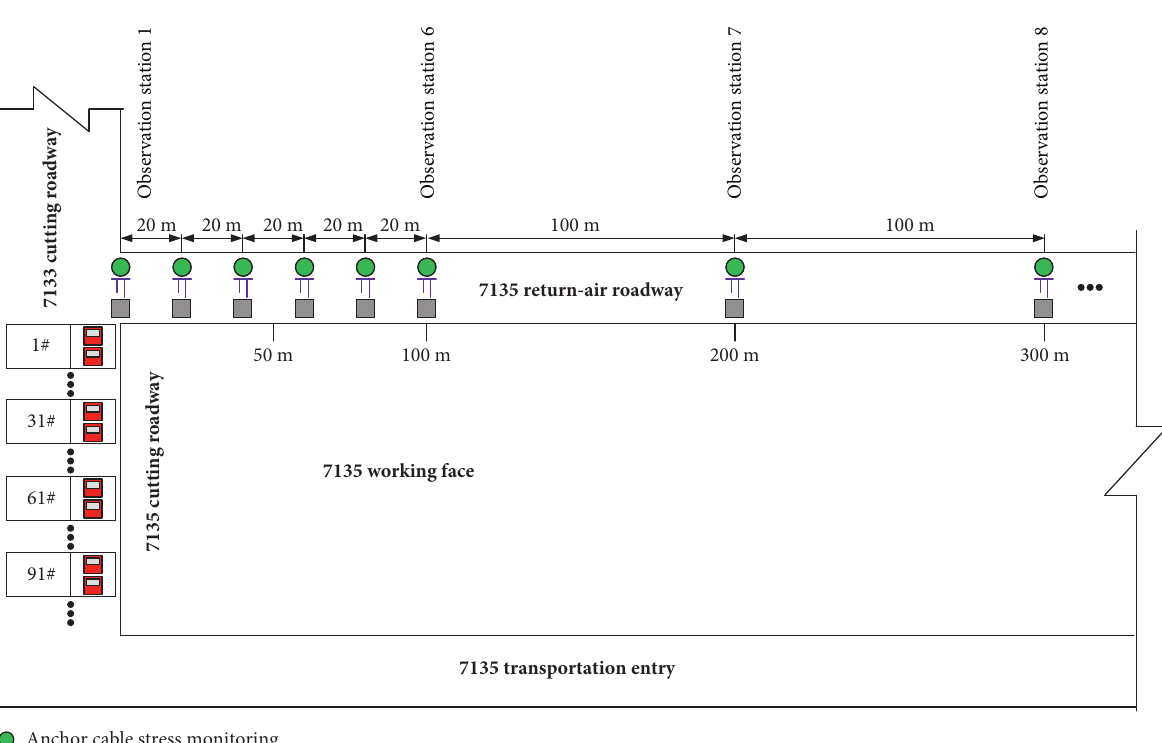
Figure 11: Setting of ground pressure observation station.